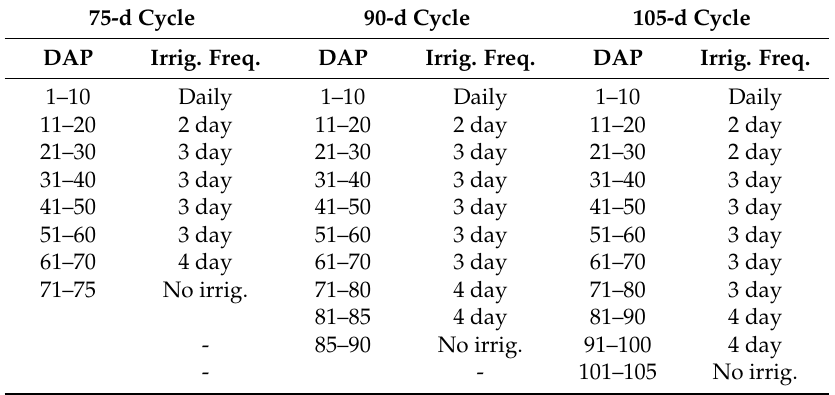
Table 2. Recommended interval between irrigation events for three crop varieties (75-d, 90-d, and 105-d growing cycles) from day 1 after planting (DAP) until the end of the cycle. 75-d Cycle 90-d Cycle 105-d Cycle DAP Irrig. Freq. DAP Irrig. Freq. DAP Irrig.